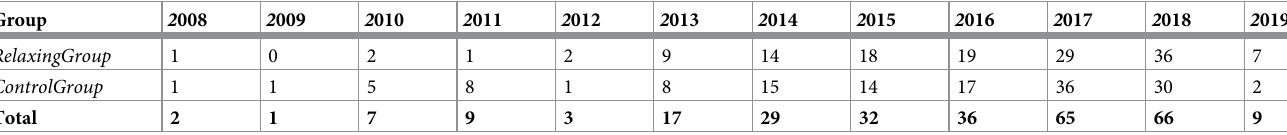
Table 1. Release years of games in the relaxing group and control group.